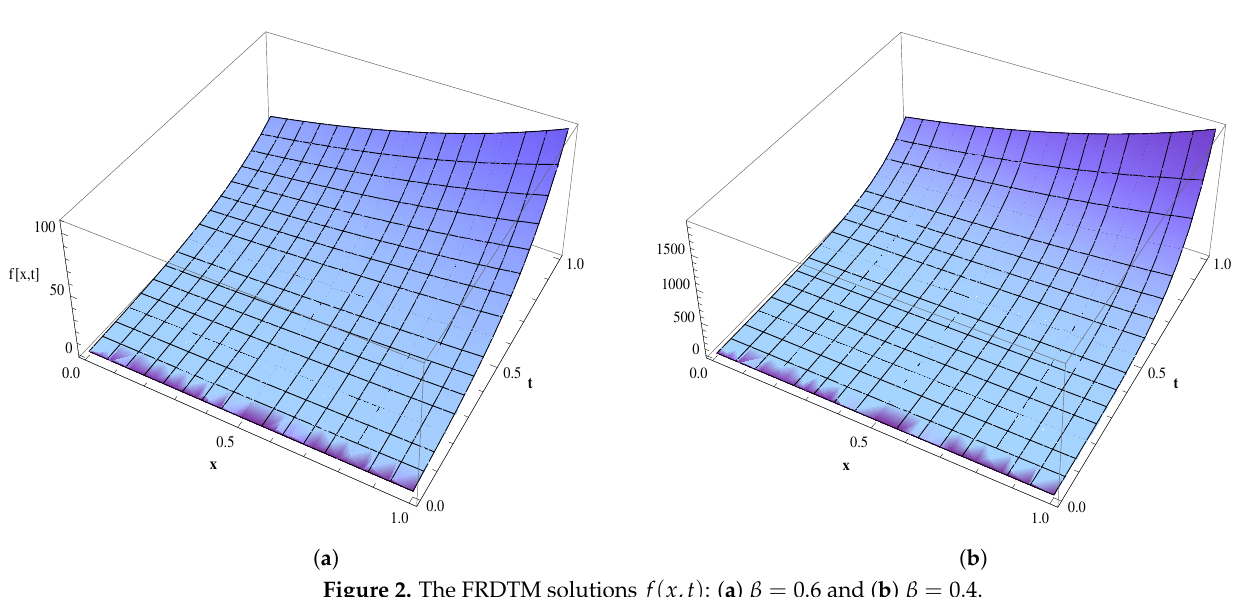
Figure 1. The FRDTM solutions f ( x , t ) : ( a ) β = 1 and ( b ) β = 0.8.